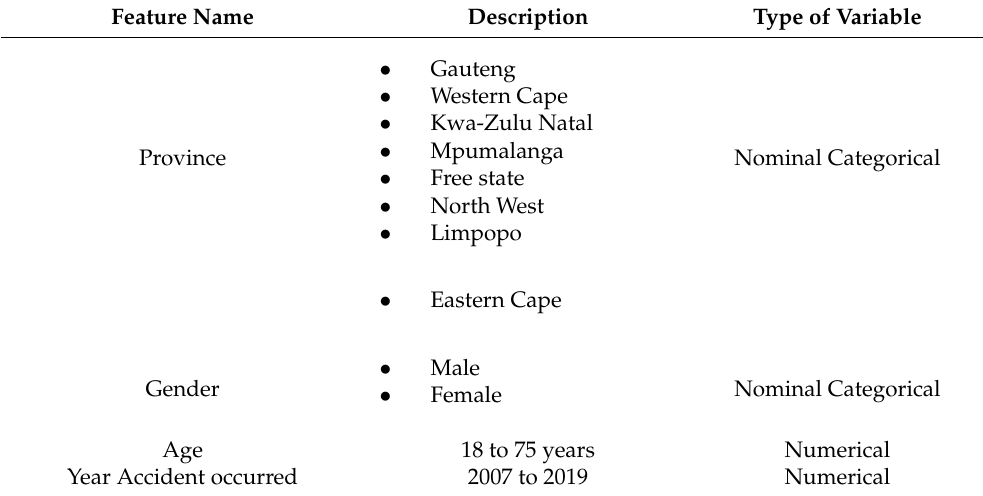
Table 1. Features used for